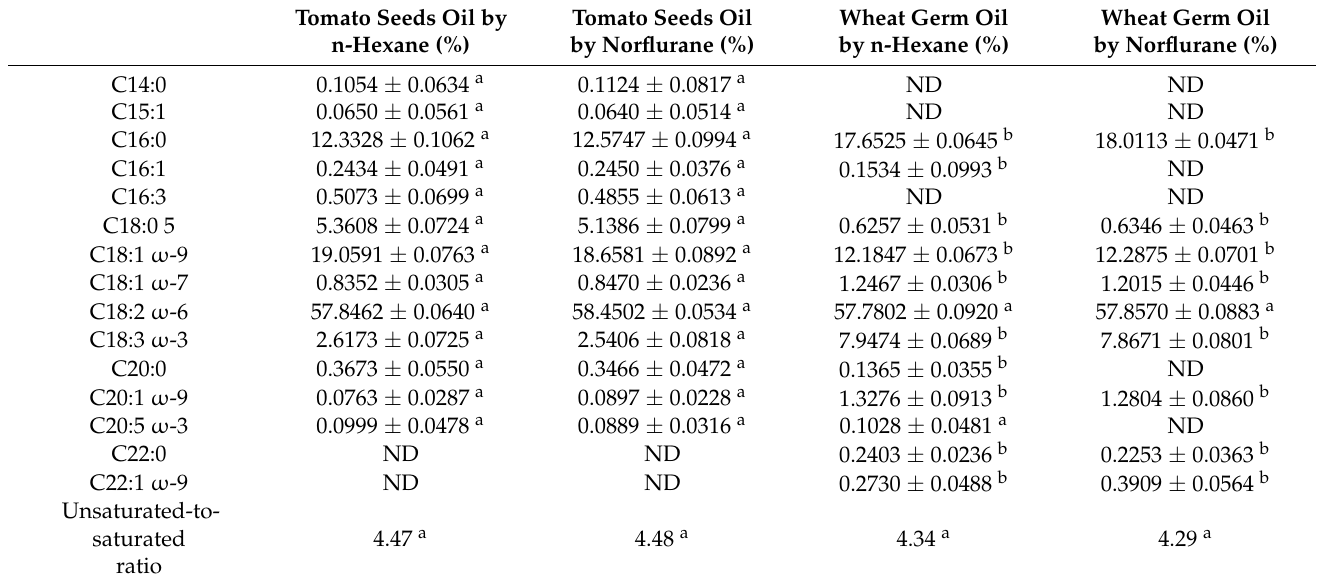
Table 5. Fatty acids profile of tomato seed and wheat germ oils extracted by Norflurane and by n-hexane.